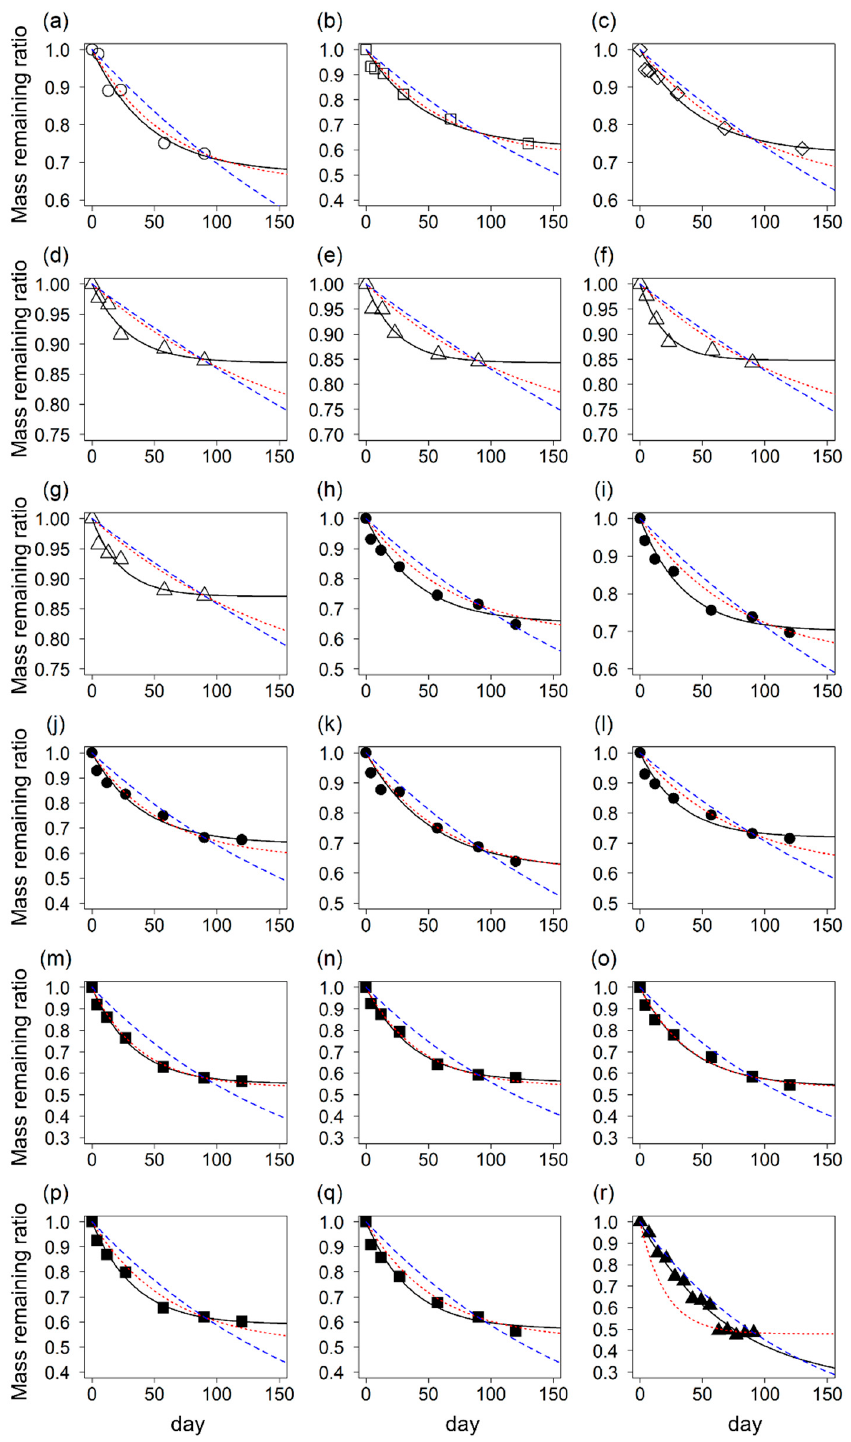
Figure 3. Mass remaining ratio of rooibos tea during incubation studies. Symbols in the figure indicate the proportion of rooibos tea remaining. Different symbol indicates different incubation condition (such as soil type and incubated temperature). Black lines indicate fitting to the asymptote mode. Dotted red lines indicate the asymptote model describing rooibos tea decomposition based on the TBI approach. Dashed blue lines indicate the single exponential model describing rooibos tea decomposition. Data were obtained from the present incubation study ( a ), Keuskamp et al. 2013 ( b , c ), Mori 2022a ( d – g ), Mori 2022b ( h – q ), and Duddigan et al. 2020 ( r ). Data points in figures b , c , and r indicate mean values.